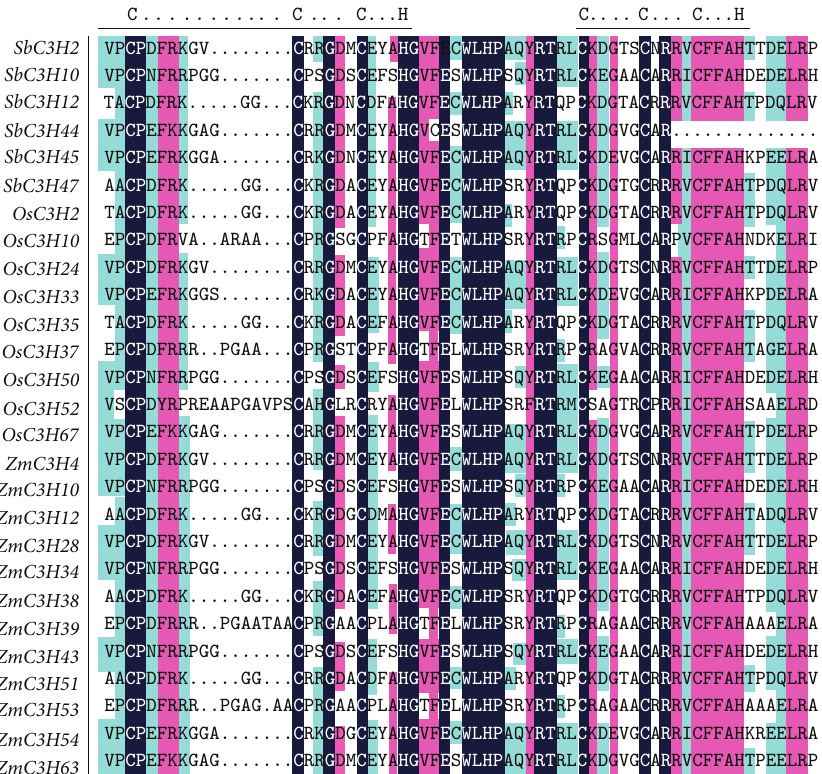
Figure 3: Alignment of the amino acid sequences of CCCH IX proteins in three grass species. Identical (100%), conservative (75–99%), and blocks (50–74%) of similar amino acid residues are shaded in deep blue, dark pink, and light blue, respectively. The conserved CCCH zinc finger motifs are indicated by straight